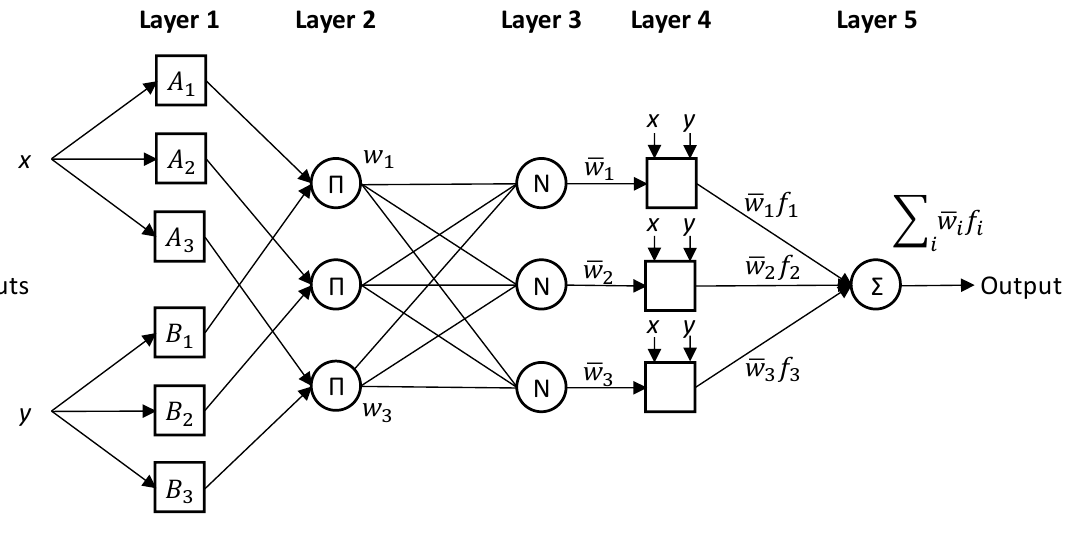
Figure 4. ANFIS structure.